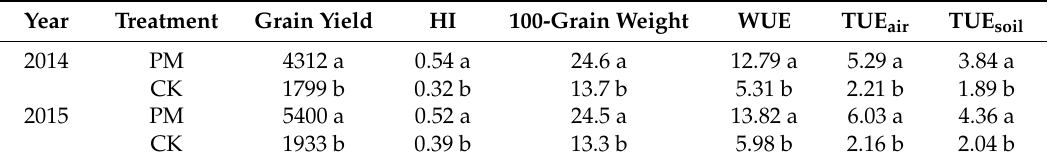
(Table 1): TUE air by 139% in 2014 and by 179% in 2015, and TUE soil by 103% in 2014 and by 114% in 2015. Table 1. Grain yield (kg ha − 1 ), harvest index (HI, kg kg − 1 ), 100-grain weight (g), water-use efficiency